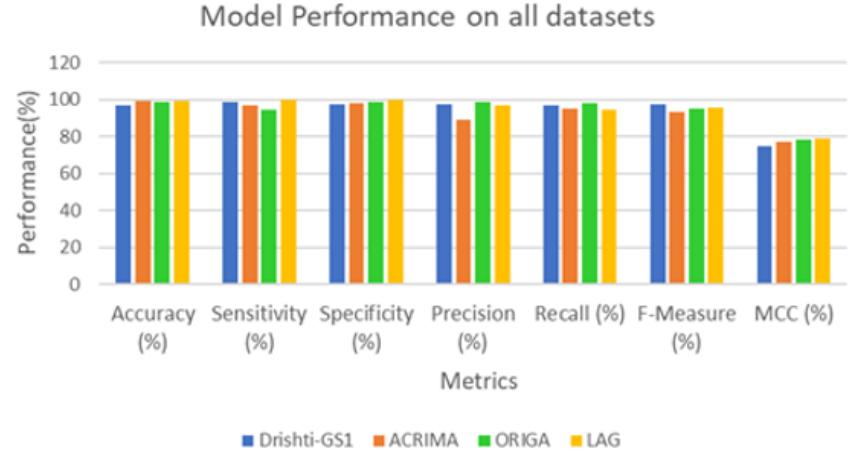
Figure 7. Results of the proposed work on all the datasets.